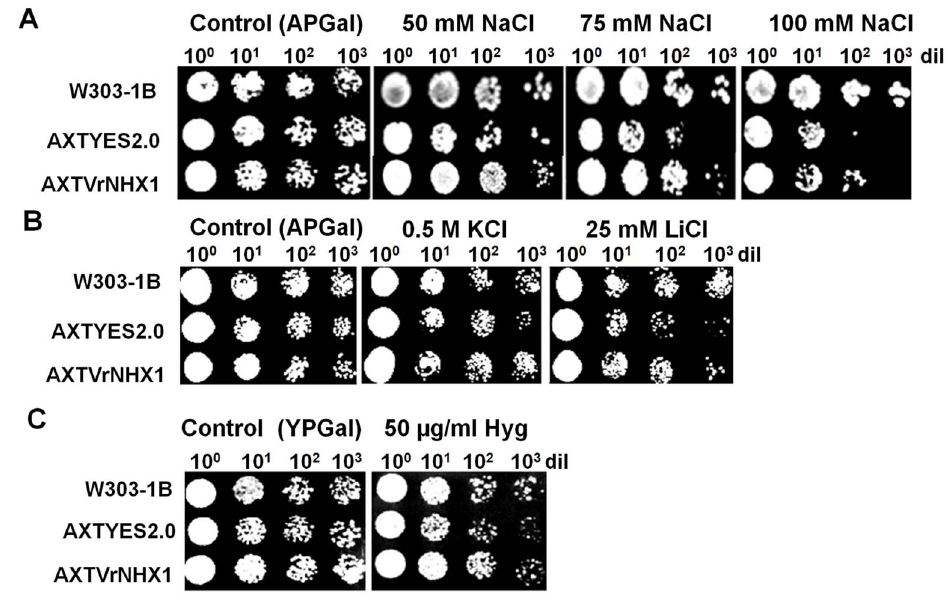
Figure 4. Heterologous expression of VrNHX1 in yeast mutant. Wild type (W303-1B) strain was used as a control, D ena1- 4 D nha1 D nhx1 mutant (AXT3) strain was transformed with null pYES2.0 (labeled as AXTYES2.0 strain) and pYES VrNHX1 recombinant vector (labeled as AXTVrNHX1) were used for complementation assay. 10-fold serial dilutions of saturated seed cultures of each strain were spotted onto APGal media (pH-5.5) supplemented with or without (A) 50, 75 and 100 mM NaCl, (B) 25 mM LiCl, and (B) 0.5 M KCl. (C) Hygromycin sensitivity assay was performed by spotting 10-fold serial dilutions of saturated seed cultures of each strain onto YPGal media (pH- 5.5) supplemented with or without 50 m g/ml Hyg. The plates were incubated at 30 u C for 3 days.